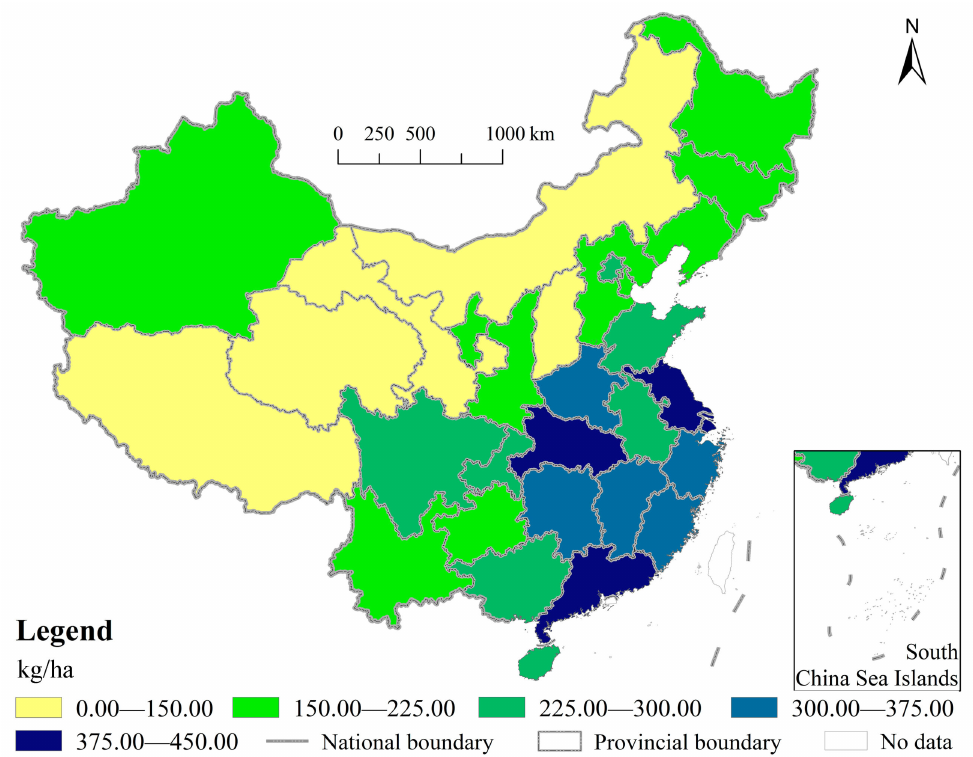
Figure 3. Spatial pattern of provincial environmental safety upper limits of CFAI in China. Due to the relative stability of natural conditions [47], we assume that the cultivated land grade of each province is the same in 2000 and 2019. Based on provincial CFAI and their environmental safety upper limits, formula (2) is employed to calculate the environmental risks of chemical fertilizer application, and ArcGIS 10.4 is used for spatial visualization (Figure 4). In 2000, there were only two types of environmental risks for provincial CFAI, namely, safety and low risk. The former included sixteen provinces, mainly distributed in the south, of which the province with the lowest risk was Jiangxi (0.36), followed by Hubei (0.43) and Hunan (0.43). The other provinces belonged to the latter, and the province with the highest risk level was Gansu (0.66), with Shaanxi (0.64) and Liaoning (0.64) being close to that level. In 2019, there were only eight provinces whose environmental risk type was safety, mainly distributed in the middle and upper reaches of the Yangtze River. Among them, the province with the lowest environmental risk was Jiangxi (0.38), followed by Shanghai (0.41) and Hubei (0.45), and the other five provinces were on the edge of the safety line. The number of provinces with a risk type of moderate risk was seven; except for Hainan, Fujian and Beijing in the east, the rest were mainly distributed in the northwest. Only the risk type of Inner Mongolia was high